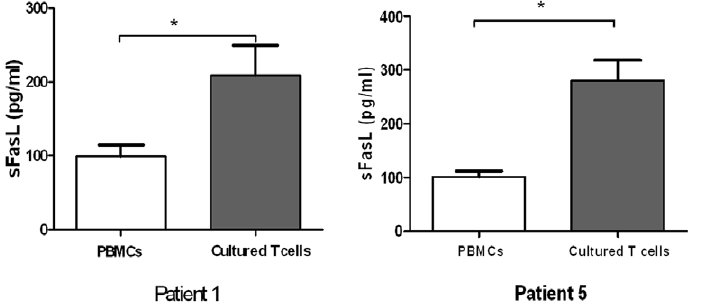
Figure 6. Comparison of sFasL release between PBMCs and cultured T cells. PBMCs from patient 1 and 5 were cultured with causal drugs for 10 days. The cells were subsequently washed, and re-stimulated with causal drugs for 3 days. The sFasL levels in supernatants were determined by sFasL ELISA kit and were compared with those in 3-day PBMC culture supernatants. Results represent mean 6 SD from three independent experiments. * P , 0.05